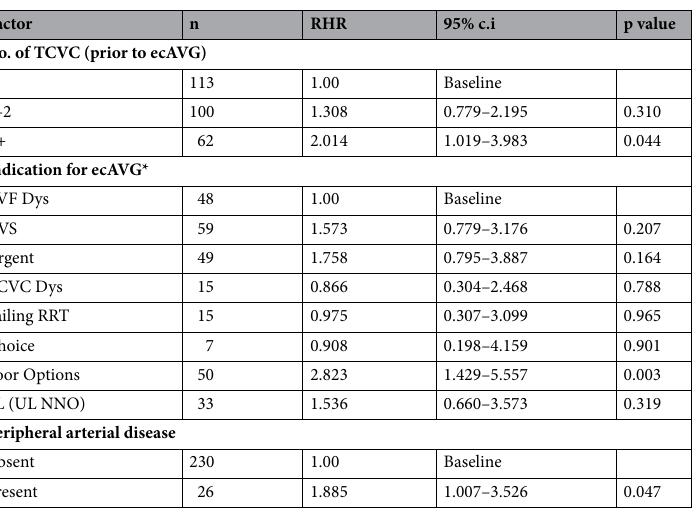
Table 5. Multi-variable analysis of risk of loss of functional patency. Model Significance: X 2 = 24.078, p = 0.034. Analysis performed after allowing for sex as a time-dependent variable, BMI as a continuous variable and age. AVF/G Dys dysfunction of an existing AVF or AVG, TCVC Dys dysfunction of a previously functioning TCVC, PNO poor native options, CVS central vein stenosis with HeRO or lower limb AVG, LL (UL NNO) lower limb AVG as upper limb had no native options, GN glomerular nephritis, Diabetes diabetes mellitus, IN interstitial